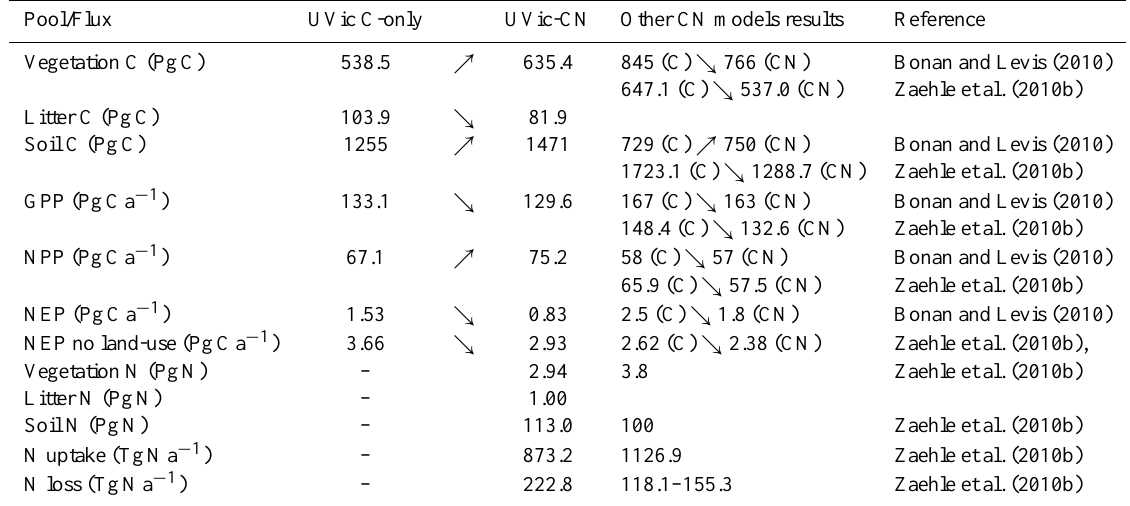
Table 6. Mean 1990s global fluxes and stocks of C and N as simulated by UVic C-only and UVic-CN driven by CO 2 concentrations. The arrows indicate increases ( % ) or decreases ( & ) when switching C/N feedbacks